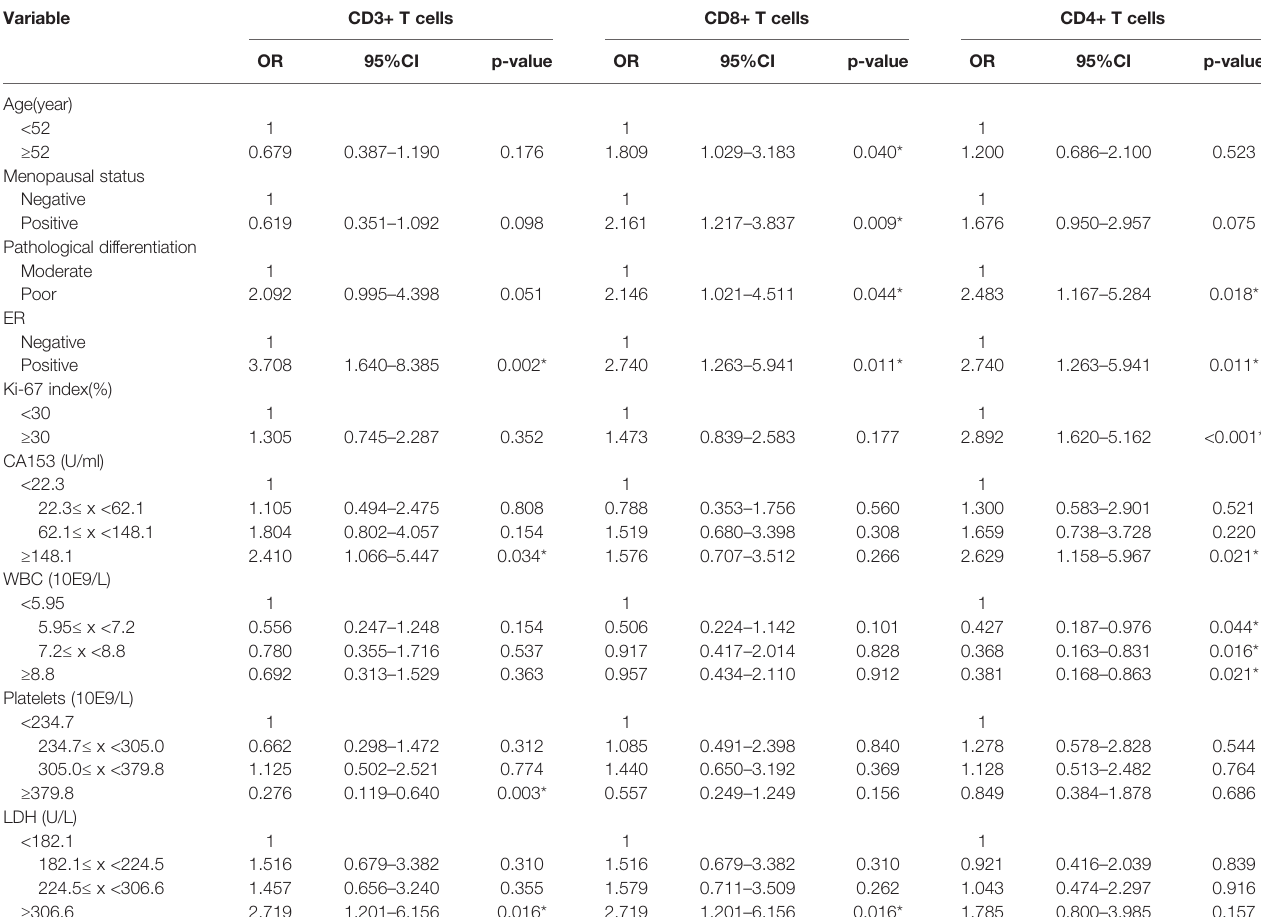
TABLE 5 | Correlative factors for tumor in fi ltrating T cells identi fi ed by univariate logistic regression analysis.